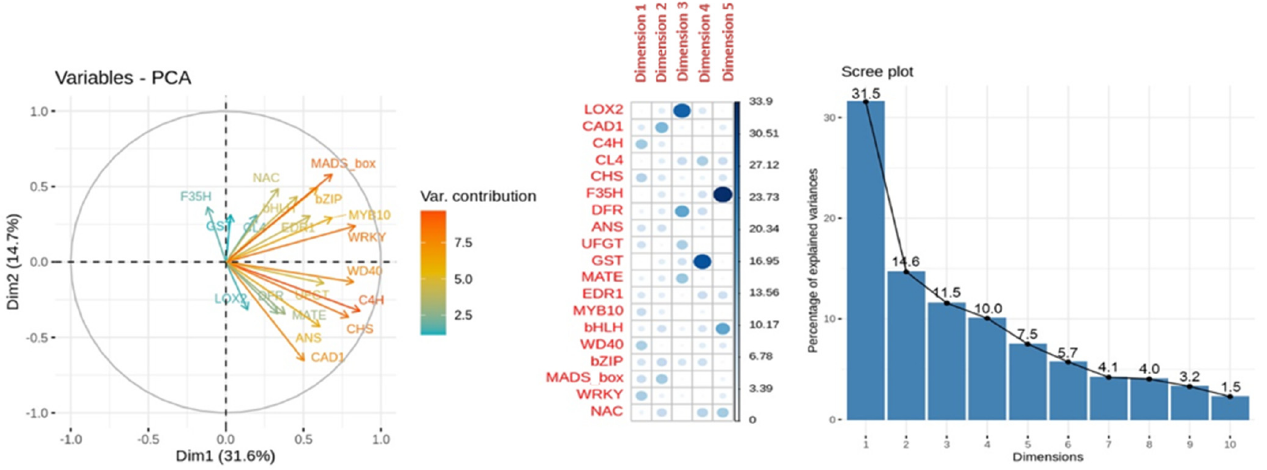
Figure 11 . Principal Component Analysis (PCA) of relative expression from anthocyanins content MLR model. From left to right: representation of the variable contribution to dimensions 1 (Dim1) and 2 (Dim 2), variable contribution and dimension correlation with the first five dimensions and percentage of explained variance of the first ten dimensions performed over the relative expression of the genes involved in anthocyanins biosynthesis ( ANS, bHLH, bZIP, C4H, CAD1, CHS, CL4, DFR, EDR1, F3 ′ 5 ′ H, GST, MATE, MADS-box, MYB10, NAC, LOX2, UFGT, WD40 and WRKY ) evaluated in apricot fruit during the ripening progression in the nine cultivars ‘Bergeron’, ‘Cebasred’, ‘Currot’, ‘Dorada’, ‘Estrella’, ‘Goldrich’, ‘Moniquí’, ‘Valorange’ and ‘Z108-38 ′ at three ripening stages green fruit, during color change and at physiological ripening.